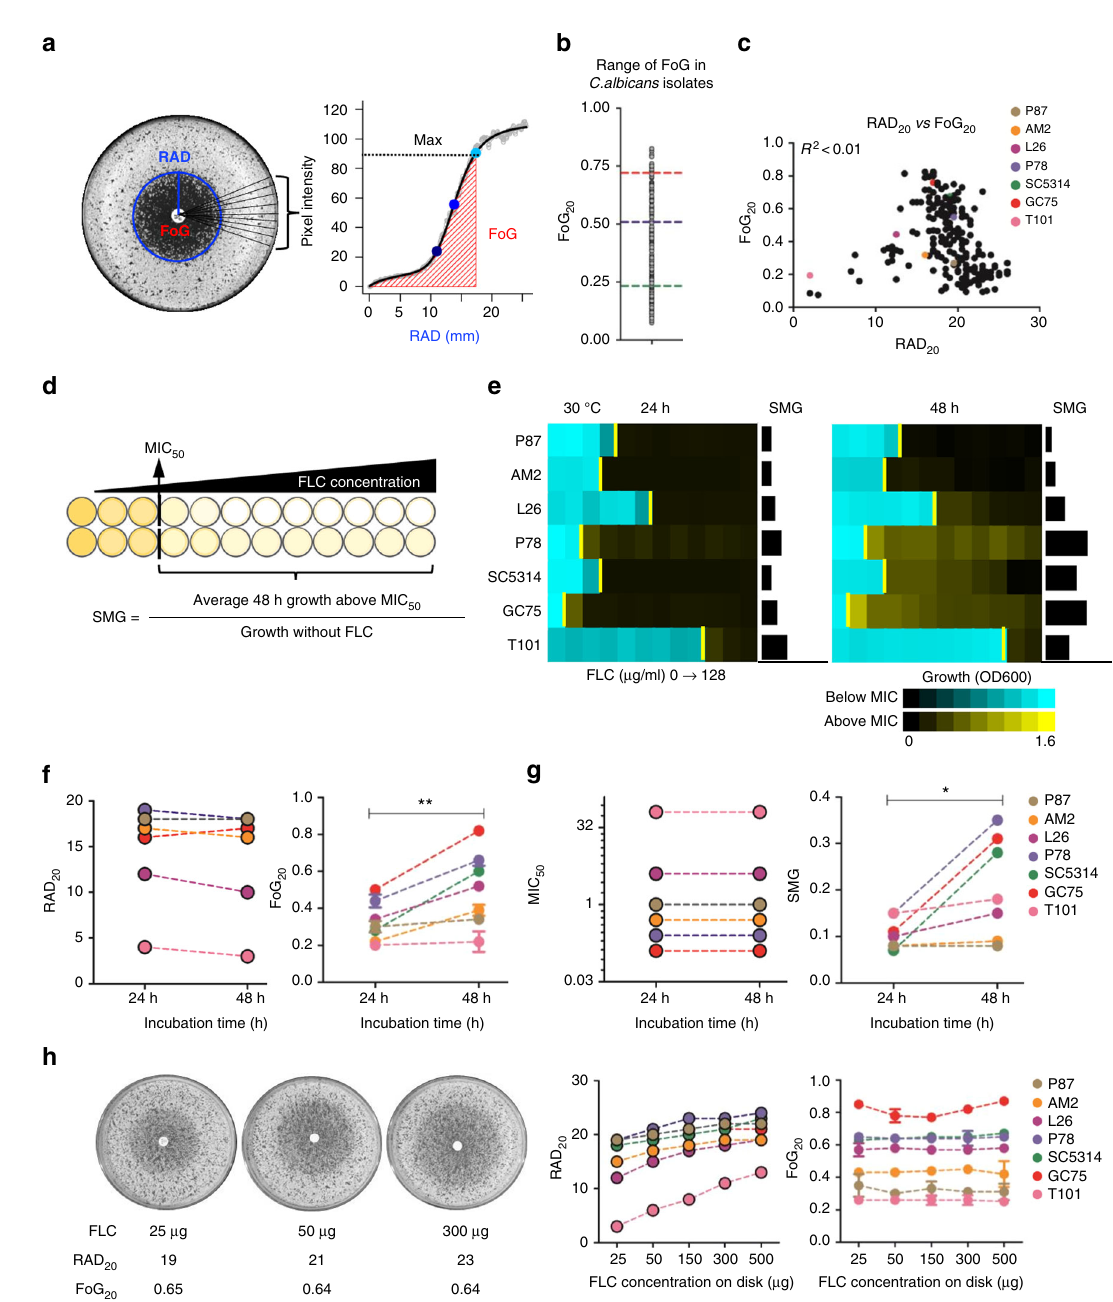
Fig. 1 Measuring drug responses in disk diffusion assays (DDAs) and in liquid broth microdilution assays (BMDAs). a diskImageR analysis measures pixel intensity corresponding to cell density, along 72 radii every 5°. The average radius (RAD) represents the distance in mm corresponding to the point where 20%, 50%, or 80% growth reduction occurs (light, medium, dark blue dots). The fraction of growth inside the zone of inhibition (FoG) is the area under the curve (red) at the RAD threshold, divided by the maximum area. b Range of FoG levels in 219 C. albicans clinical isolates. Red, blue, and green lines estimate high, medium, and low FoG levels, respectively. Unless otherwise speci fi ed, DDAs were performed using a single 25 µ g FLC disk and analyzed after 48 h at 30 °C. c Comparison of FoG 20 and RAD 20 for the 219 isolates. d Illustration of MIC and supra-MIC growth (SMG) calculations. MIC 50 was calculated at 24 h as the FLC concentration at which 50% of the growth was inhibited, relative to growth in the absence of drug. SMG was calculated as the average growth per well above the MIC divided by the level of growth without drug. FLC was used in two-fold dilutions (0, 0.125 to 128 μ g/ml). e Heatmaps illustrating OD 600 levels for concentrations below the MIC (yellow bar) in cyan and above the MIC in yellow for the isolates from Fig. 1c. Maps show OD 600 values at 24 and 48 h. f , g Effect of incubation time on RAD/MIC and FoG/SMG values. diskImageR analysis ( f ) and corresponding MIC and SMG levels ( g ) measured at 24 and 48 h for strains as in d . Of note, for truly drug-resistant strains such as T101 (MIC = 64, e ), the small zone of inhibition makes FoG measurements less accurate than SMG levels. h RAD is concentration-dependent and FoG is concentration-independent as illustrated for strain SC5314 exposed to disks containing increasing concentrations of FLC (25, 50 and 300 µ g) (left); RAD (middle) and FoG (right) levels for strains as listed. For all panels, n ≥ 2; ** P < 0.01; * P <